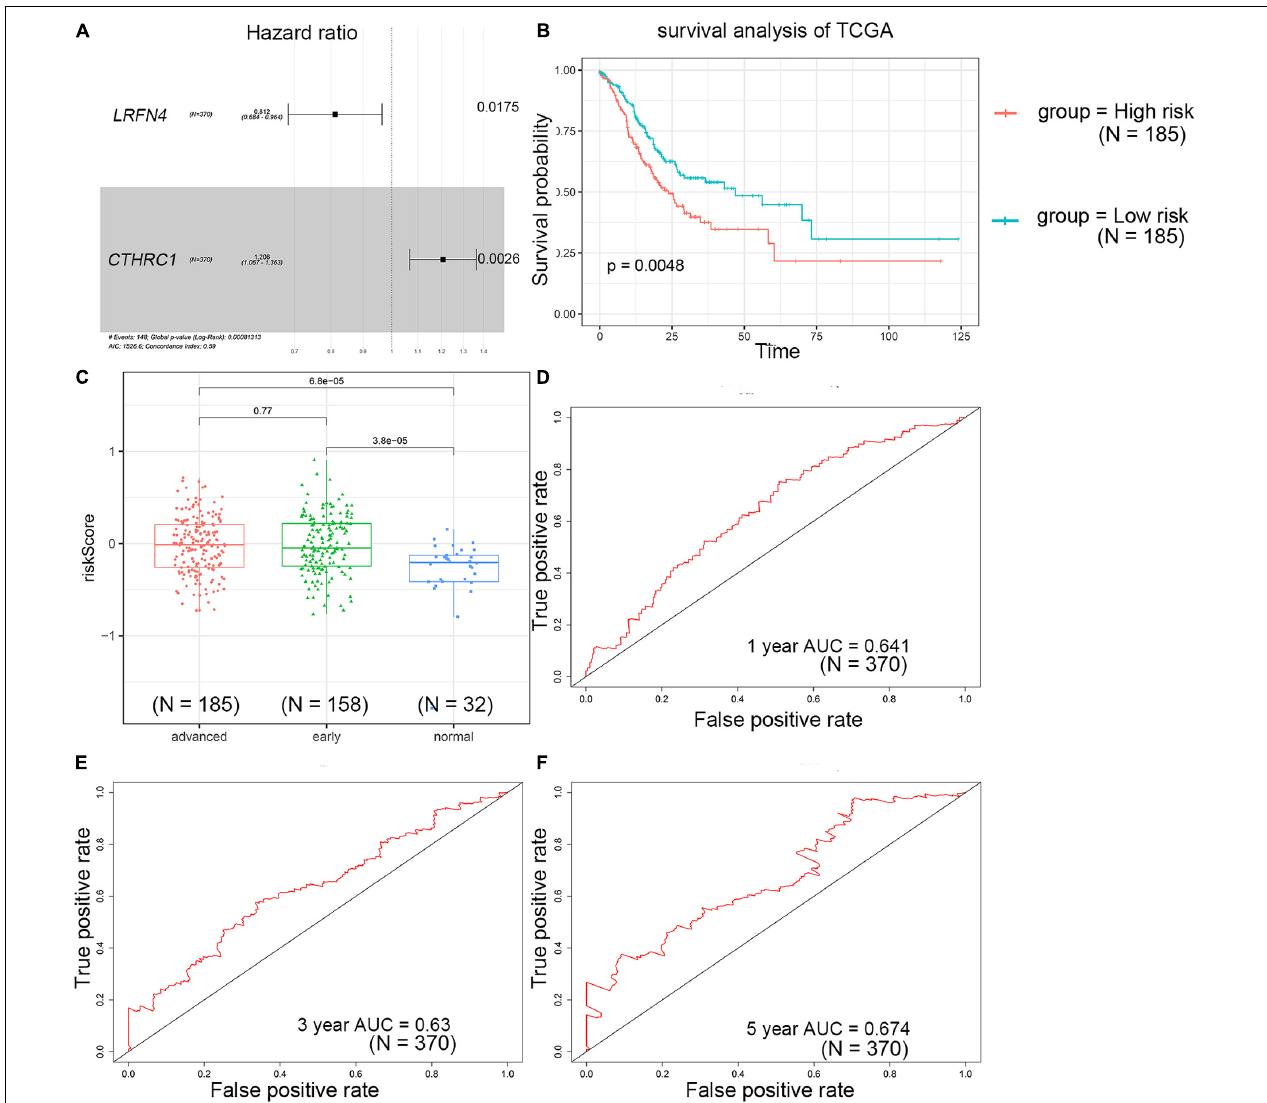
FIGURE 3 | Prognostic value detection of LRFN4 and CTHRC1 via multivariate Cox regression analysis in patients with STAD of TCGA dataset. (A) Multivariate Cox regression analysis of LRFN4 and CTHRC1. (B) Survival analysis of the high-risk group and the low-risk group in the TCGA dataset. (C) Risk score in early stage and advanced stage of STAD in TCGA sets. (D–F) ROC curve of the prognostic signature in the TCGA